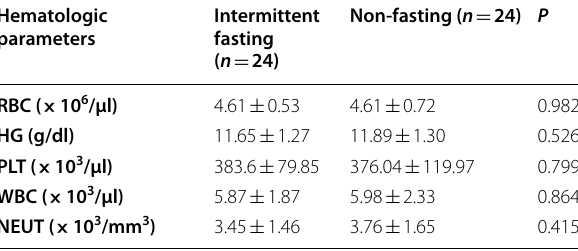
Table 4 Comparison between the two studied groups according to hematologic parameters after cycle